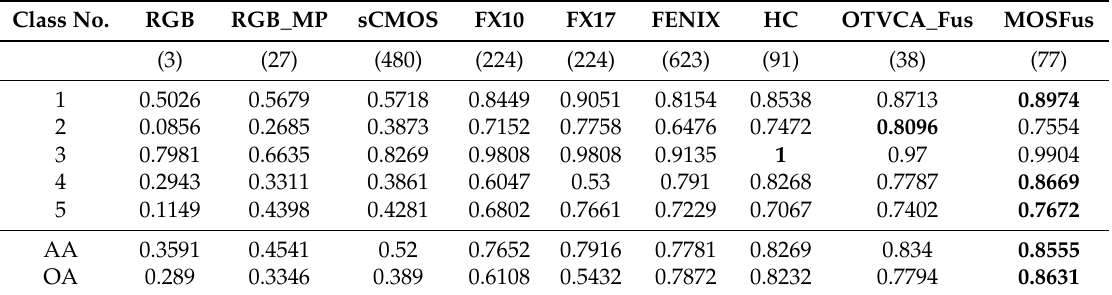
Table 5. The classification accuracies of different fusion techniques and different sensors using SVM applied on the RZ2 dataset. The number of features used is given in brackets and the highest accuracy in each row is shown in